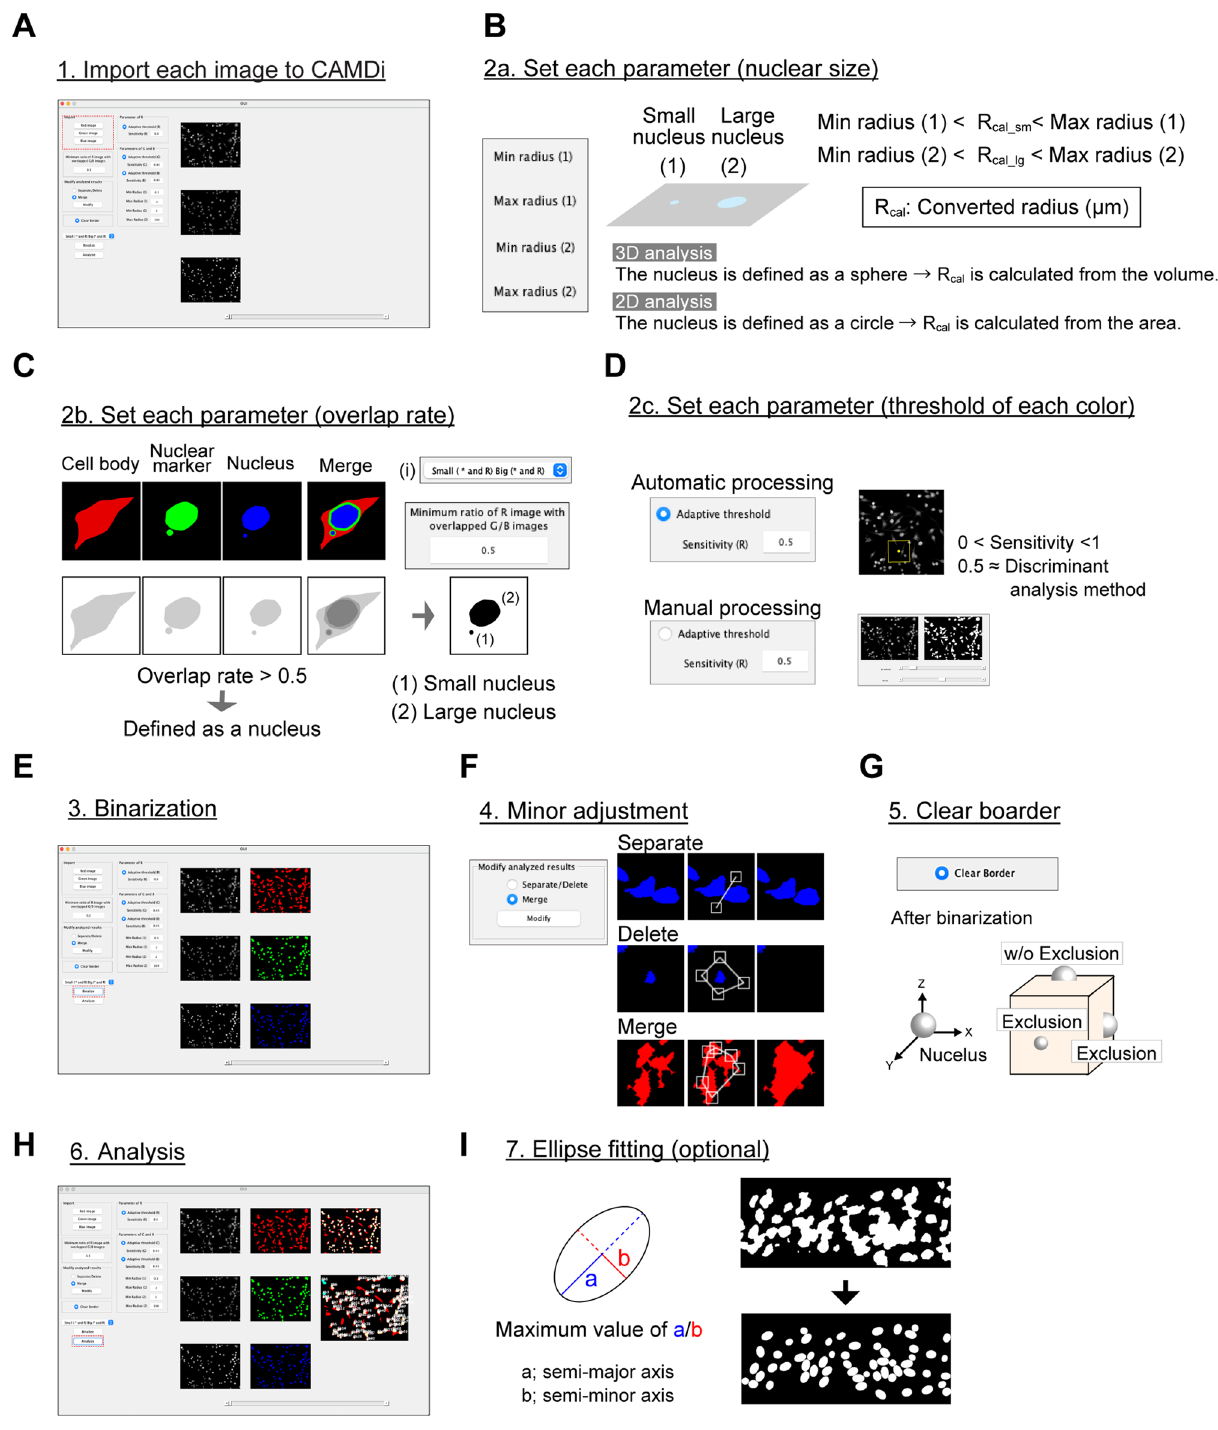
Figure 3. Processing flow of the MATLAB-based program, CAMDi. ( A ) The TIFF images are imported into CAMDi. ( B ) Definition of the size of the nucleus, (1) small nucleus, and (2) regular nucleus. ( C ) Definition of the overlapped rate: the default value is 0.5. Both overlapped areas and non-overlapped areas can be selected using window (i). ( D ) Definition of the threshold of signals. The discriminant analysis method is applied when automatic processing is selected. ( E ) Original images are converted into binarized images. ( F ) Merged or divided signals in the binarized images are corrected. ( G ) Signals on the border can be eliminated using this function. ( H ) Each data can be acquired after analysis. The result data are exported as csv files. ( I ) High-density signals are effectively separated using the ellipse fitting function. This function can only be used on the Microsoft Windows platform to date. Adobe Creative Could CC (Photoshop 22.1.0 and Illustrator 25.0.1) (https:// www. adobe. com/) was used for all image processing and illustration preparation in Fig.